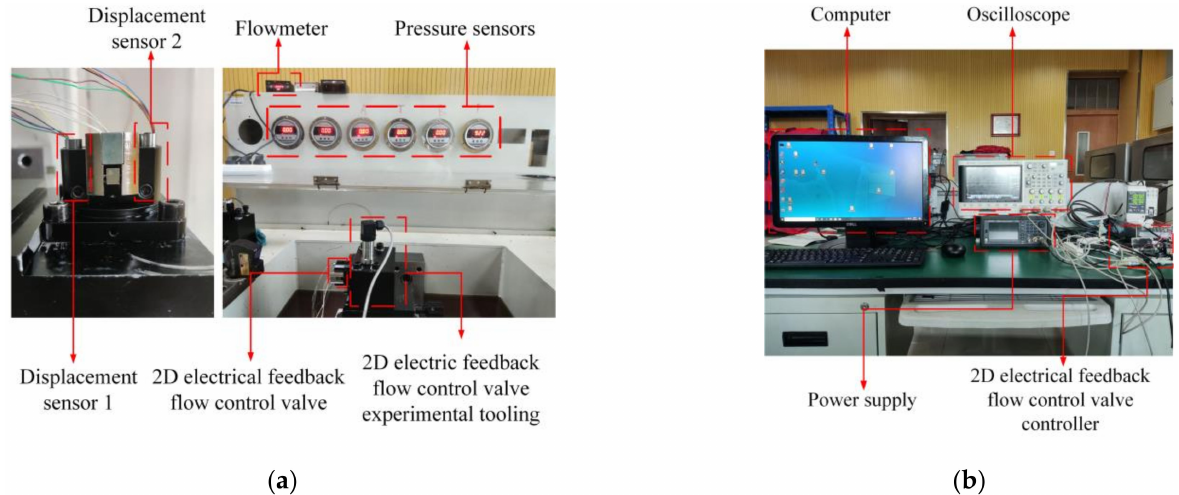
Figure 16. Test bench and some experimental equipment. ( a ) Actual picture of the experimental platform; ( b ) real picture of experimental equipment.